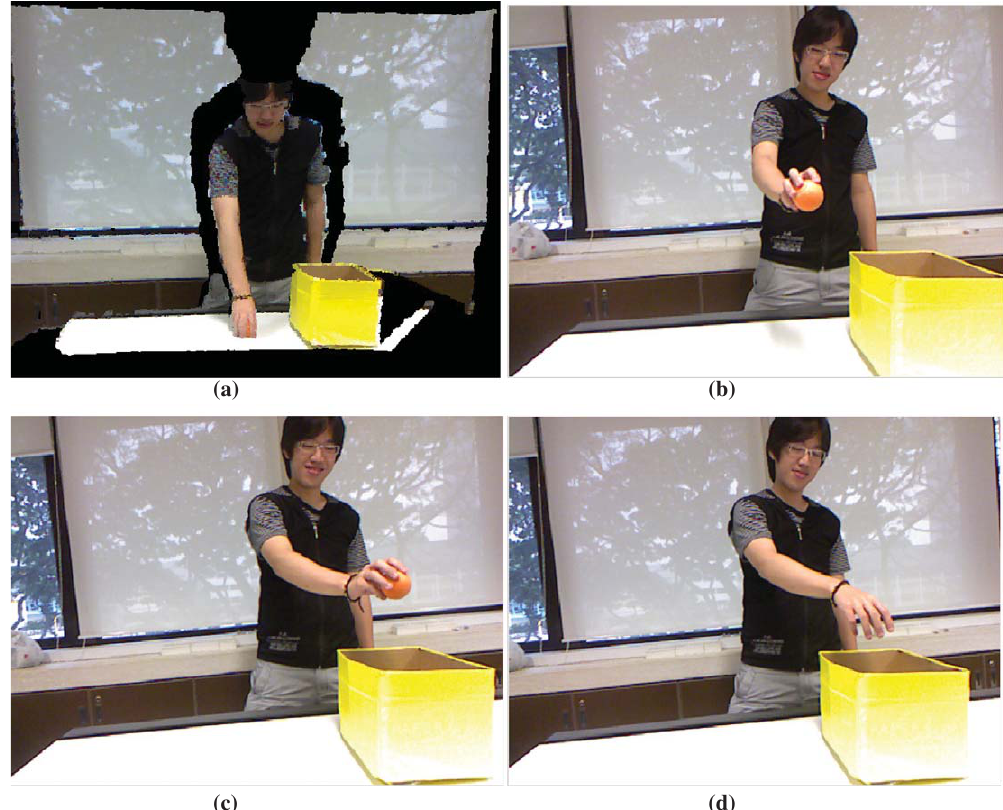
Fig. 4. One of the demonstrators performing the Pick and Drop task. The robot is placed in front of the demonstrator observing the task.